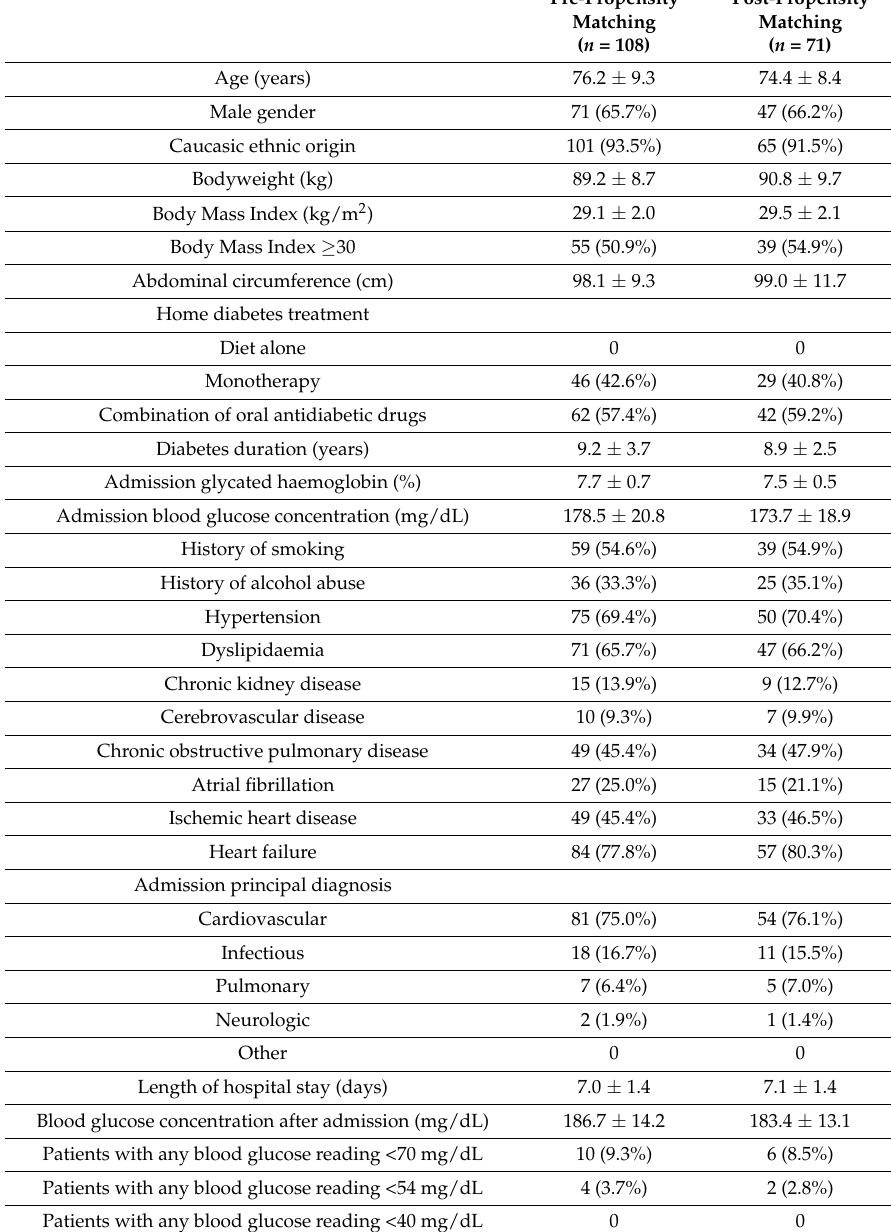
Table 4. Pre- and post-propensity matching clinical characteristics and glycaemic control of hospitalized patients with type 2 diabetes on linagliptin-basal group with treatment failure or mean blood glucose reading >200